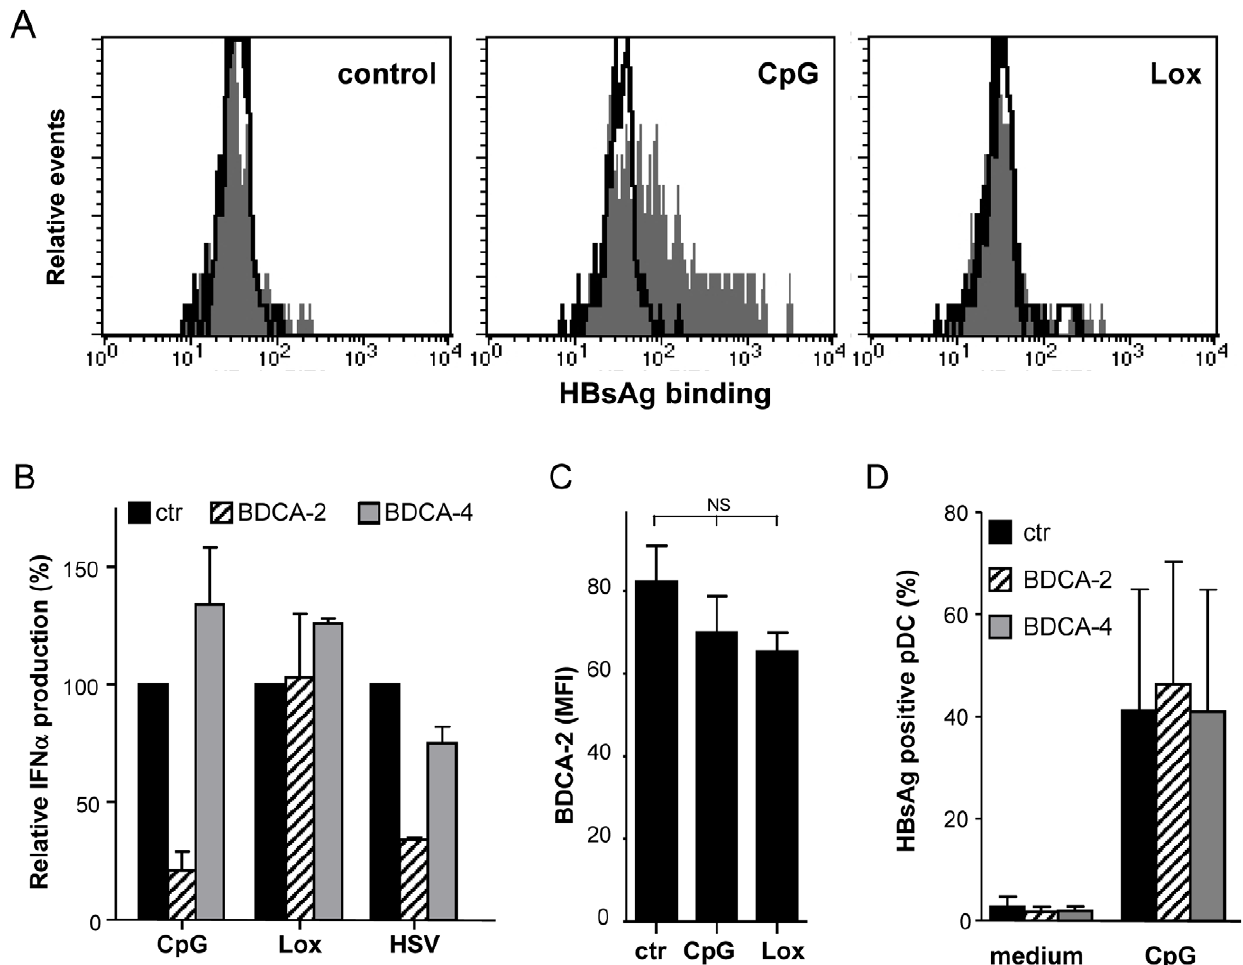
Figure 8. HBsAg preferentially binds to CpG-activated pDC. A : pDC were cultured with or without Lox or CpG and with or without HBsAg. After 4h, cells were harvested and surface bound HBsAg was detected by flow cytometry. Data are representative for 5 independent experiments. Open: HBsAg detection in cultures without HBsAg; Filled: HBsAg detection in cultures with HBsAg. B : PBMC were cultured in the presence of CpG, Lox or HSV-1 either with or without anti-BDCA-2 or BDCA-4. IFN a production in pDC was detected by flow cytometry. Data show mean 6 SD relative IFN a production compared to cultures without BDCA-2/4 crosslinking for 2 independent experiments. C : pDC were cultured with or without CpG or Lox for 24h. Data show mean 6 SEM BDCA-2 expression as assessed by flow cytometry of 5 independent experiments. NS: not significant. D : PBMC were cultured with or without CpG and with or without HBsAg. After 4h, cells were harvested and surface bound HBsAg was detected on pDC by flow cytometry. Data show mean 6 SEM HBsAg positive pDC of 5 independent experiments.